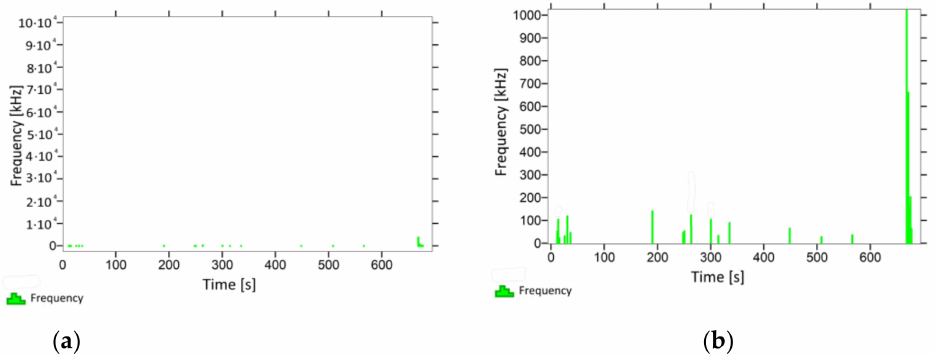
Figure 15. Graph of frequency distribution during the test for a representative sample from series P 14 : ( a ) considering the entire occurring frequency range and ( b ) with details about the frequency range before the moment of